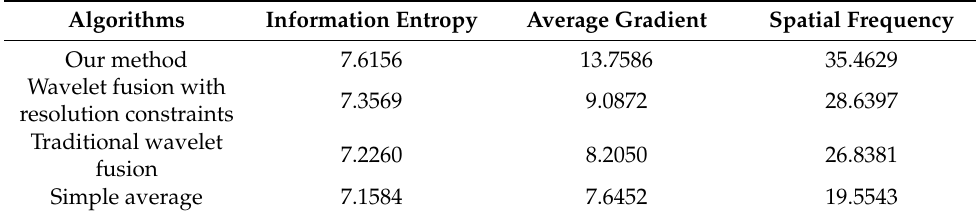
Table 4. Comparison of fusion results of different methods in Area 1.